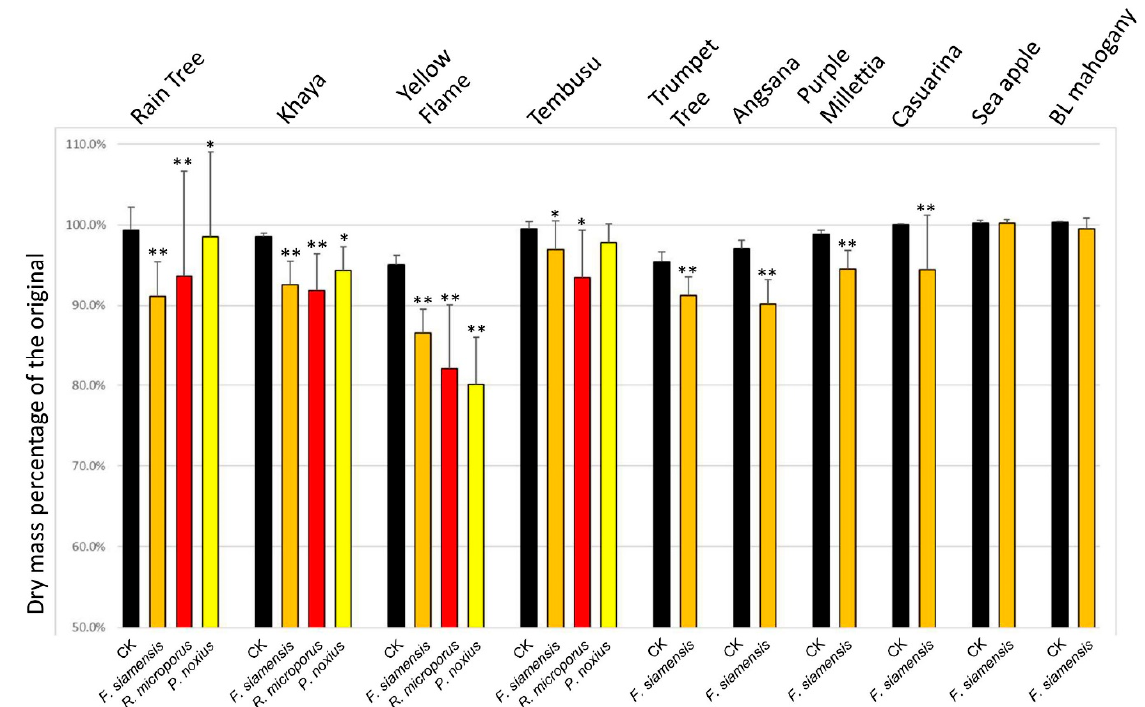
Figure 9. In vitro wood decay studies. Double autoclaved dry wood blocks (30 × 10 × 8 mm) were incubated with PDA Petri dishes (90 mm diameter) fully colonized by the respective fungi. Dishes were sealed and incubated at 28 °C for 12 weeks. After removing the fungus and drying, the wood blocks were weighed and presented as percentages of their original weights (n = 20 for each inoculation). CK: reference group, wood blocks going through the same procedure but without fungus inoculation (n = 20). ** Very significant difference between a treatment group and its reference group (CK) by Student’s t -test ( p < 0.01); * Significant difference from CK by Student’s t -test (0.01 < p < 0.05).